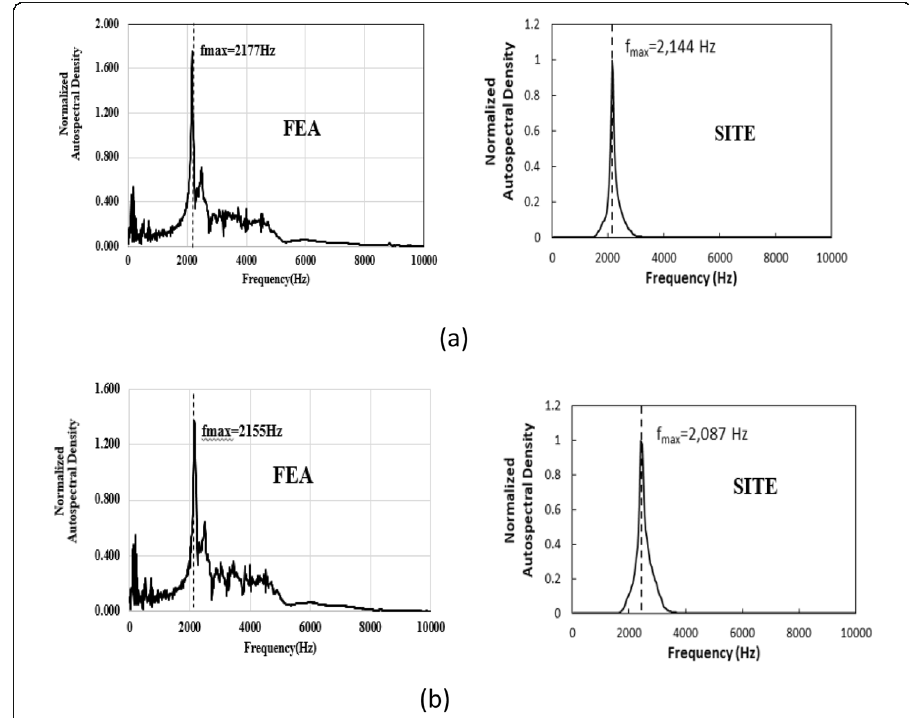
Fig. 27 Comparison of results from the FEA and site testing: a Cavity size (40 cm × 40 cm × 1.5 cm). b Cavity size (40 cm × 40 cm × 1 cm)